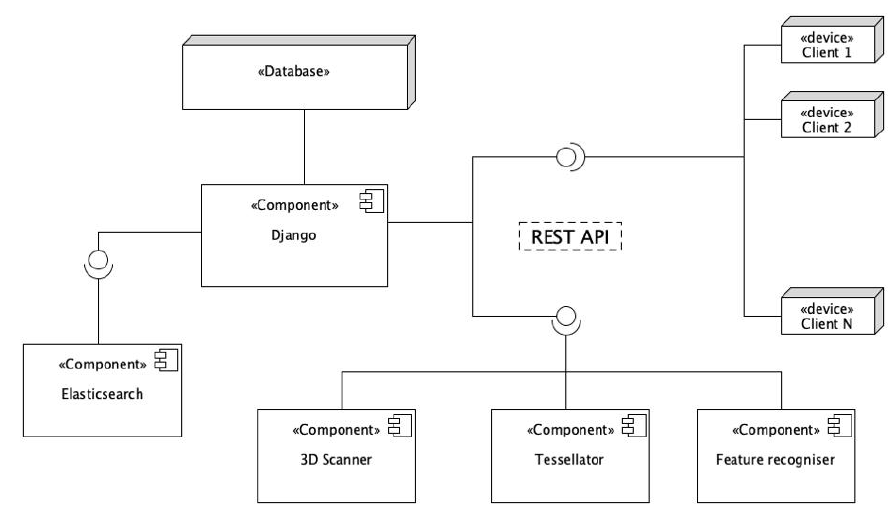
Figure 3. Application component diagram.